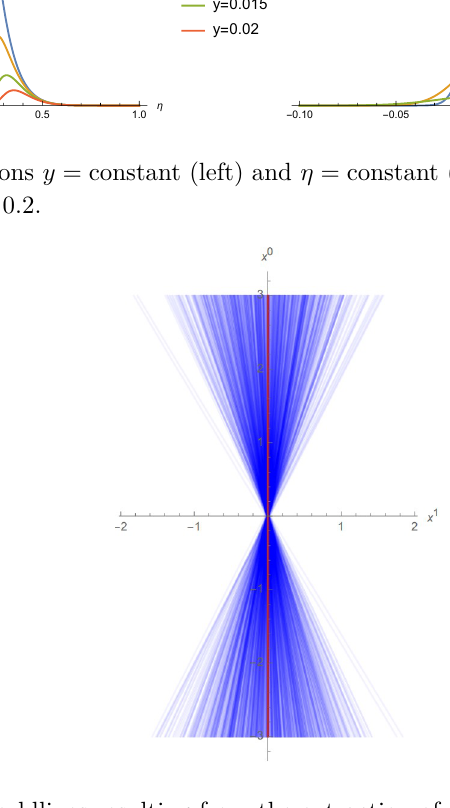
Figure 3 . Bundle of worldlines resulting from the extraction of 1000 points from the distribution H ( v, B ) defined in (5.6). The red worldline corresponds to the center of the distribution, with ( p, q ) = (0 , 0) . Each worldline has an opacity of 0 . 05